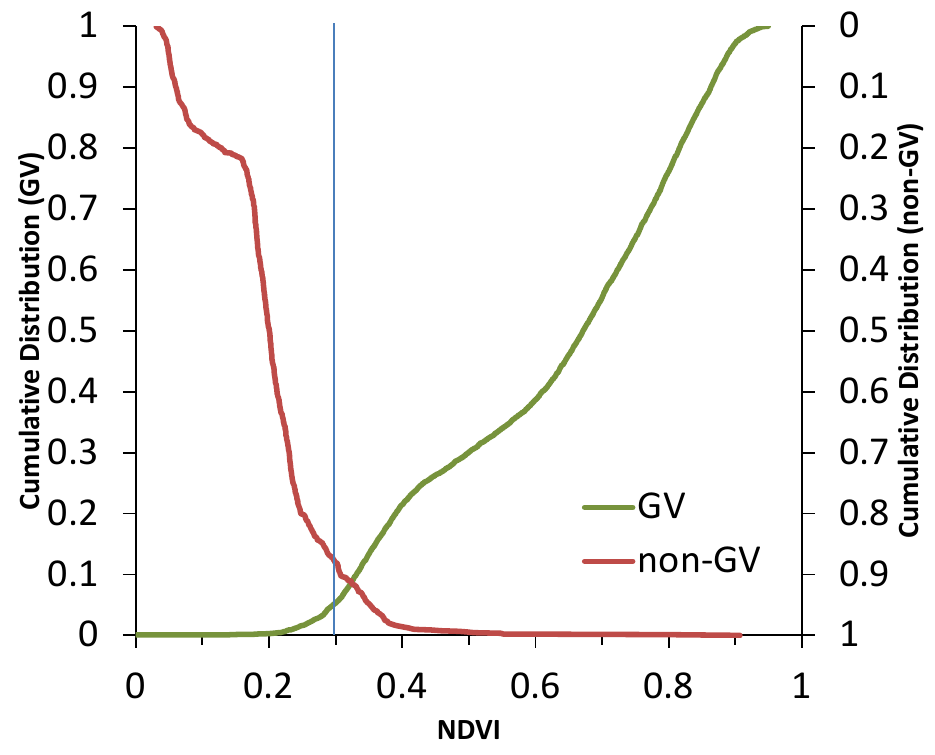
Figure 3. An NDVI threshold of 0.3 was empirically determined using spectra extracted from species reference polygons (GV) and from areas with senesced grassland and soil cover (non-GV). Non-GV cover was identified based on appearance in high resolution orthoimagery and manual inspection of spectral shape in the July 2011 AVIRIS image. 95% of GV-type spectra were above the 0.3 NDVI threshold, while only 12% of non-GV-type spectra were above the same